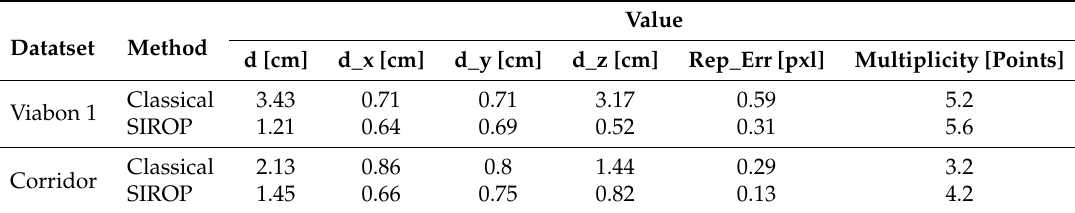
Table 2. Comparison between two methods on two datasets: euclidean distance on GCPs, average tie-point reprojection error and manifold.